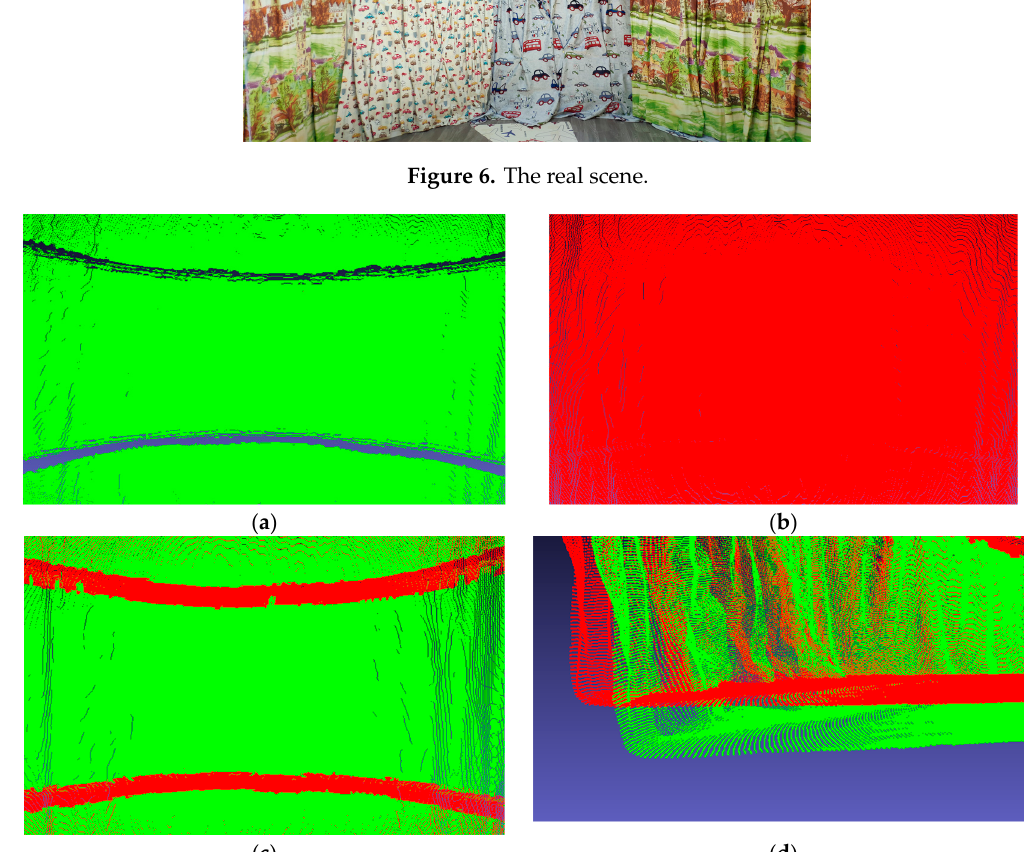
Figure 7. Point cloud fusion results of real scene. Red point clouds are the result of our method. Green point clouds are the result of method C. ( a ) and ( b ) are the results of method C and our method, respectively. ( c ) is the front of the real scene. ( d ) is the ground of the real scene.